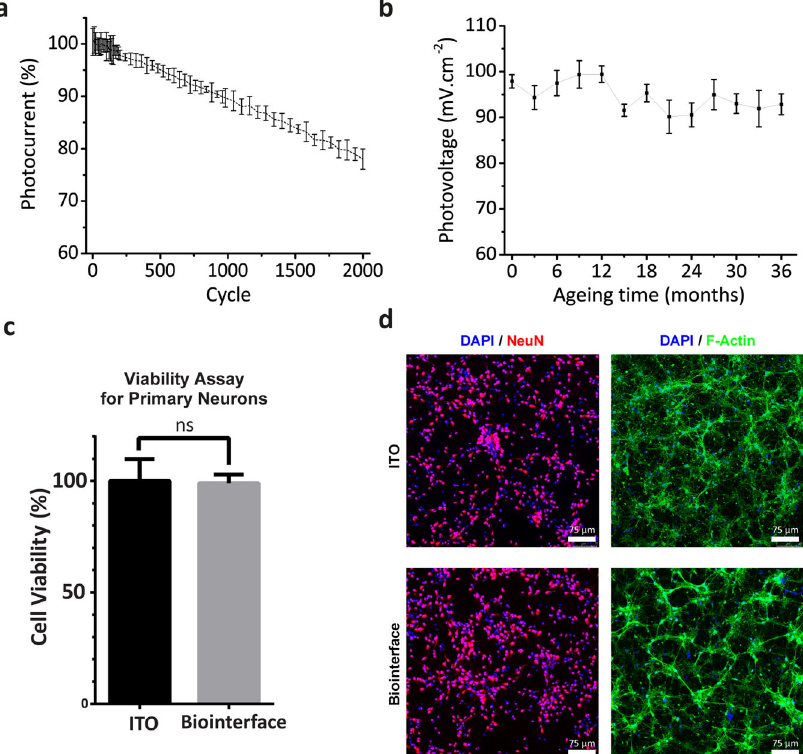
Fig. 4 Device stability and biocompatibility in vitro. a Cyclic photostability of the biointerface. Photocurrent peaks were measured in periodic cyclic illumination and measurements were normalized to analyze cyclic stability. Blue LED at the nominal wavelength of 445 nm with the frequency of 2 Hz, pulse width of 20 ms, and intensity of 100 mW cm − 2 was used. b Chronopotentiometry measurements during passive accelerated ageing test to reveal photovoltage generation performance. Biointerfaces were placed in physiological saline solution at 87 °C in dry oven under dark conditions for 810 h to simulate the ageing for 36 months. Chronopotentiometry measurements were repeated in each 68 h (mean ± s.d., n = 6). c The effect of the biointerface on metabolic activity of primary hippocampal neurons was examined by MTT viability assay and compared with ITO control. An unpaired two-tailed t -test was performed to determine the level of signi fi cance. Each experiment was carried out with at least four biological replicates (mean ± s.d., n = 4). * p < 0.05 was considered as statistically signi fi cant, and nonsigni fi cant differences are presented as “ ns ” . d Immuno fl uorescence images of primary hippocampal neurons on the biointerface and ITO controls. Primary hippocampal neurons co-stained with DAPI (blue), Anti-NeuN (red), and Anti-F-actin (green) (scale bar: 75 μ